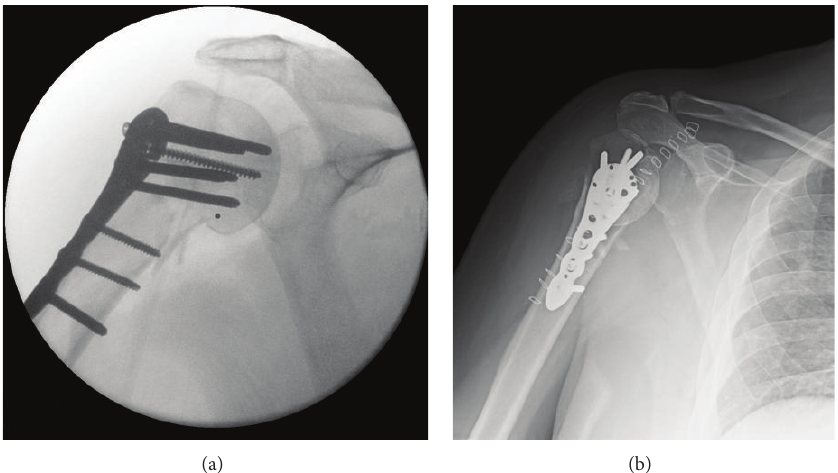
Figure 2: Radiograph showing the proximal humerus after reconstruction with a plate and screws (a) during surgery and (b) 14 days later when the screws had pulled out from the humeral head.